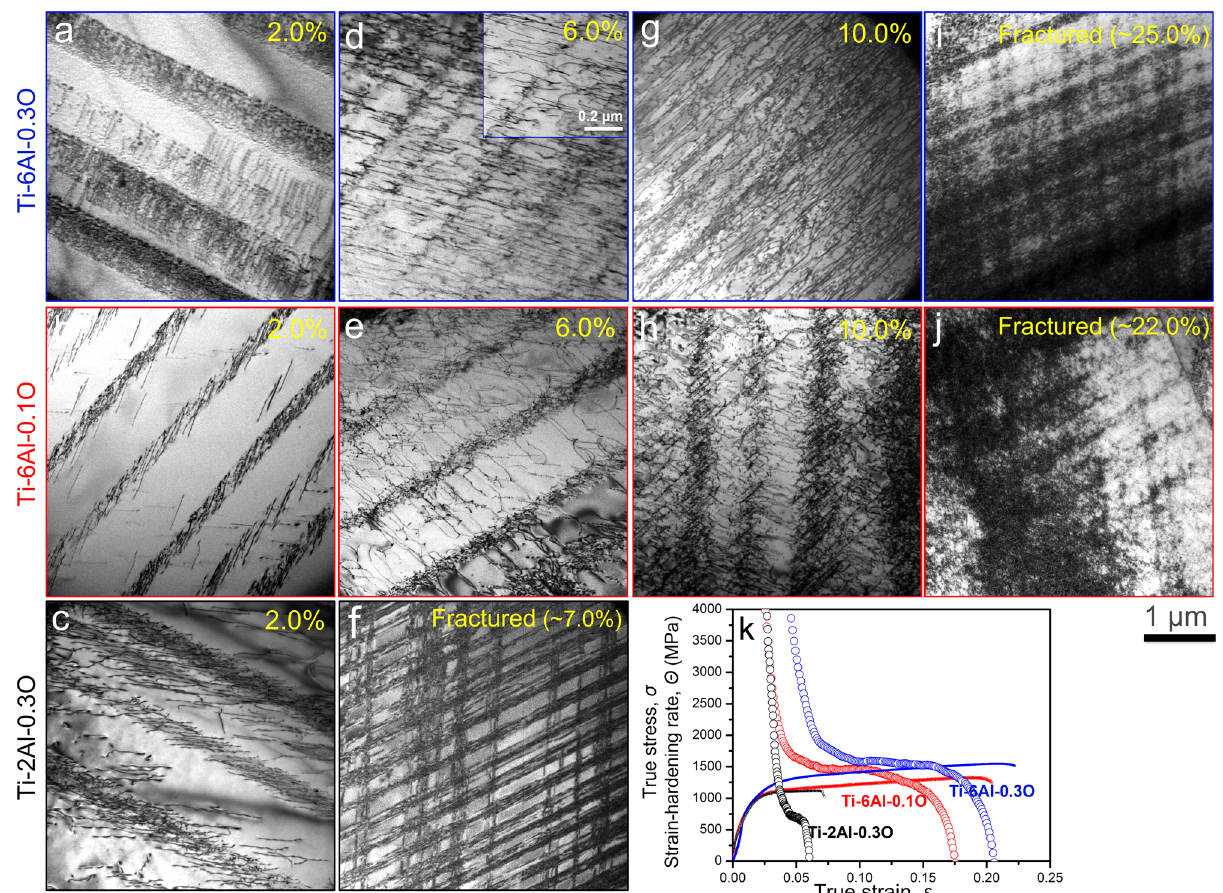
Fig. 3 Typical dislocation morphologies of Ti-2Al-0.3 O, Ti-6Al-0.1 O, and Ti-6Al-0.3O alloys after tensile deformation at a cryogenic temperature at selected strains and eventual fracture. The corresponding strain-hardening rate curves of the three alloys ( k ) are also given for reference. At the early stage of deformation (2.0%) a – c planar slip bands were observed in all three alloys. With further increase of deformation (from 6% to fracture), the localized deformation became even severe in Ti-2Al-0.3 O alloy f , whereas in Ti-6Al-0.1O and Ti-6Al-0.3 O alloys, a clear delocalization of deformation occurred as dislocations entanglements and possible cross-slips were frequently observed in between the planar slip bands e , h , j and d , g , i . In Ti-6Al- 0.3 O alloy, the delocalization occurred even earlier than in Ti-6Al-0.1 O alloy. The scale bar applies to all panels in this fi